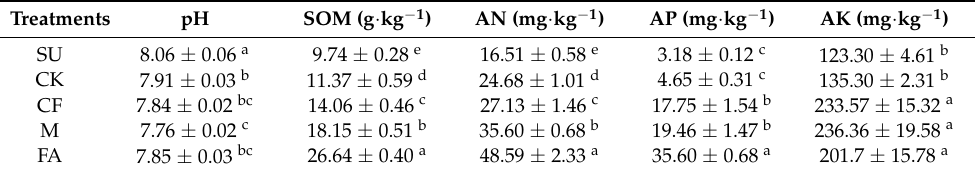
Table 1. Soil chemical characteristics in different treatments.